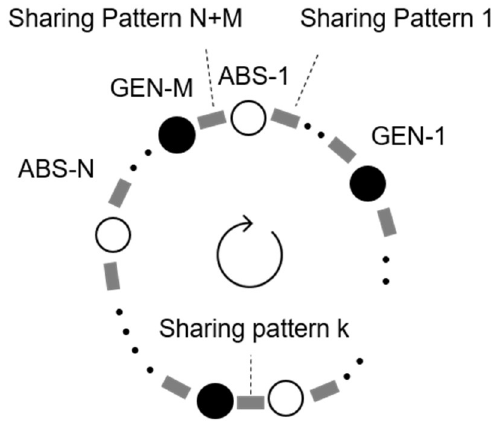
Figure 3. Order of the phases with each sharing pattern and the absorption/generation processes.